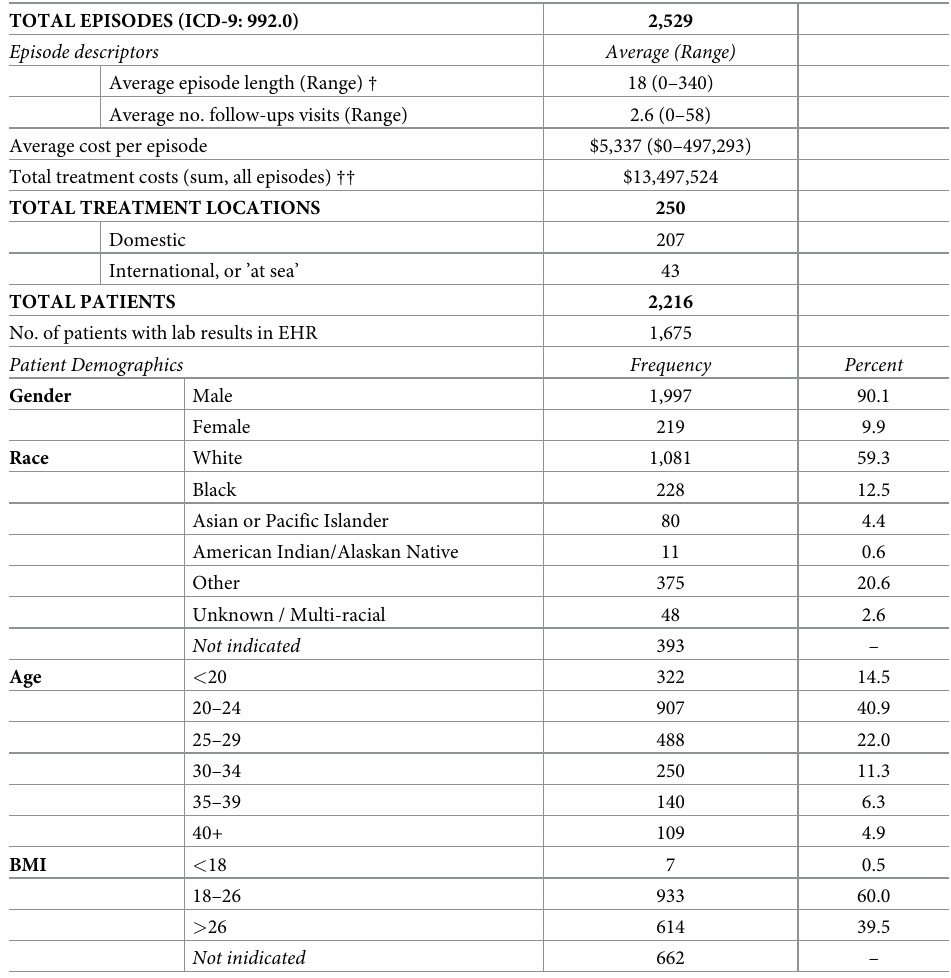
Table 1. Episode, treatment and patient descriptors. TOTAL EPISODES (ICD-9: